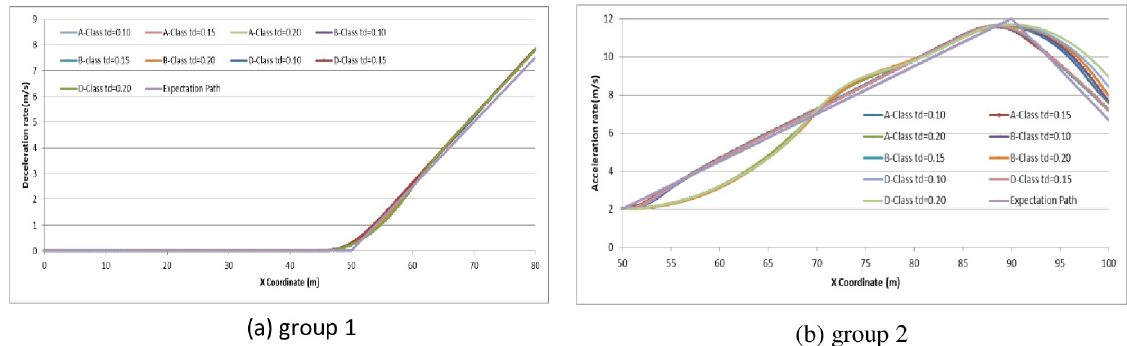
Fig 16. Comparison diagram of operation time delay in different vehicle models at initial speed = 30 km/h.